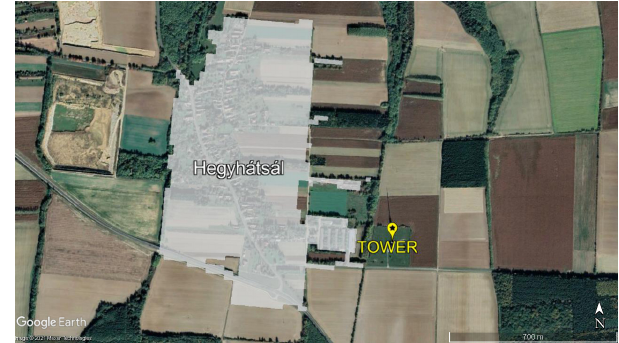
Figure 3. Definition of the territory of the village based on land cover information. The shaded area covers the buildings, roads in the village, and vegetated areas in artificial environments (parks, backyards, etc.). © Google